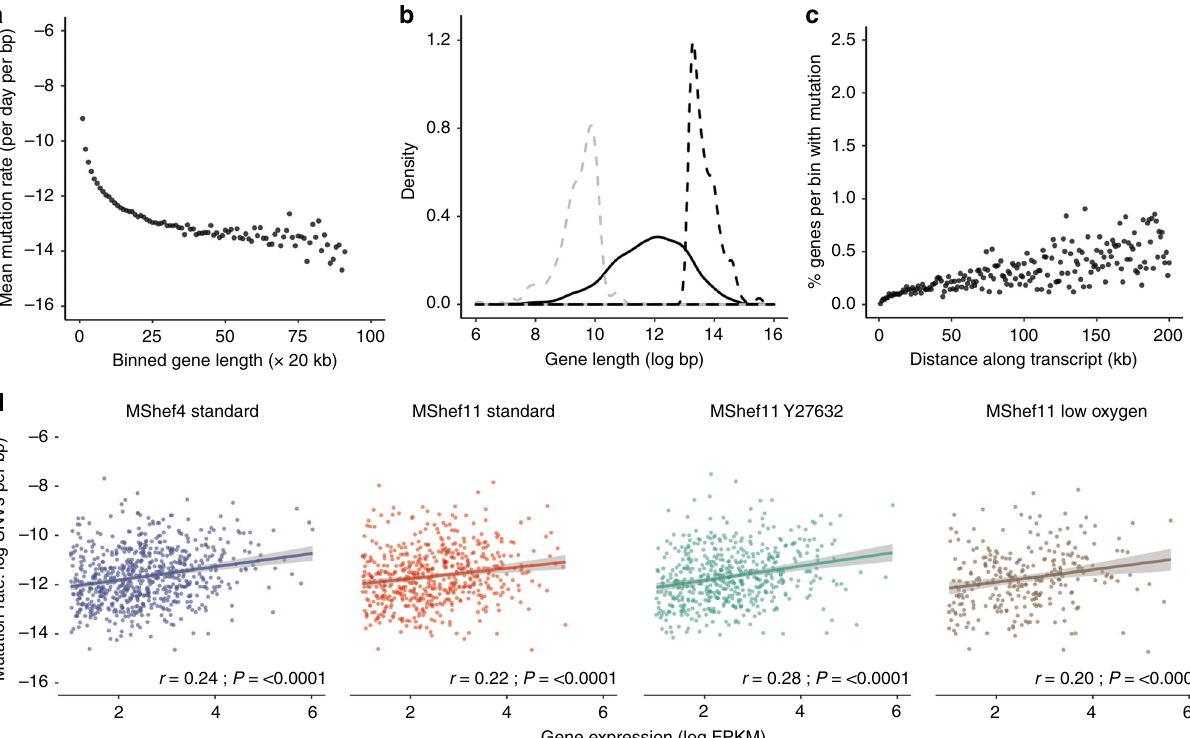
Fig. 5 Relationship between gene size, expression, and mutation. a Dot plot showing the mutational load of genes in relation to their size. Mutated genes from all growth-condition groups were binned by size into 20 kb bins. Dots represent individual bins containing genes of increasing size; the y -axis indicates the mean number of mutations per base-pair for each bin (natural log scale). Mutational load decreased with increasing gene size. b Density plot showing the distribution in gene size for the 10% of genes with highest mutation load (dashed grey line) compared to an equal number of the least-mutated genes (dashed black line) and to all mutated genes (solid black line). Genes with a high mutational burden were small compared to the overall size distribution and were signi fi cantly smaller than genes with a low mutational burden. c Dot plots showing the percentage of mutated genes per subclone with occurrences of mutation at increasing distances from transcription start sites (TSS). The x -axis denotes distance from the TSS (kb); the y -axis shows the percentage of genes within each bin that harbour mutation. The data show increasing mutation prevalence with increased distance from TSS. d Scatter plots showing of the relationship between mutational load ( y -axis) and gene expression ( x -axis) in MShef4 and MShef11 under all conditions (natural log scale). Plots indicate a weak positive correlation between expression and mutation. Solid coloured lines indicate the fi tted linear regression models for each group; shaded regions around regression lines indicate 95% con fi dence intervals for the models. Spearman correlation test statistics and P- values are shown for each group (MShef4 standard:.rho = 0.24; MShef11 standard: rho = 0.22; MShef11 + Y27632: rho = 0.28; MShef11 low oxygen: rho = 0.2). Source data are provided in Supplementary Data 4 and